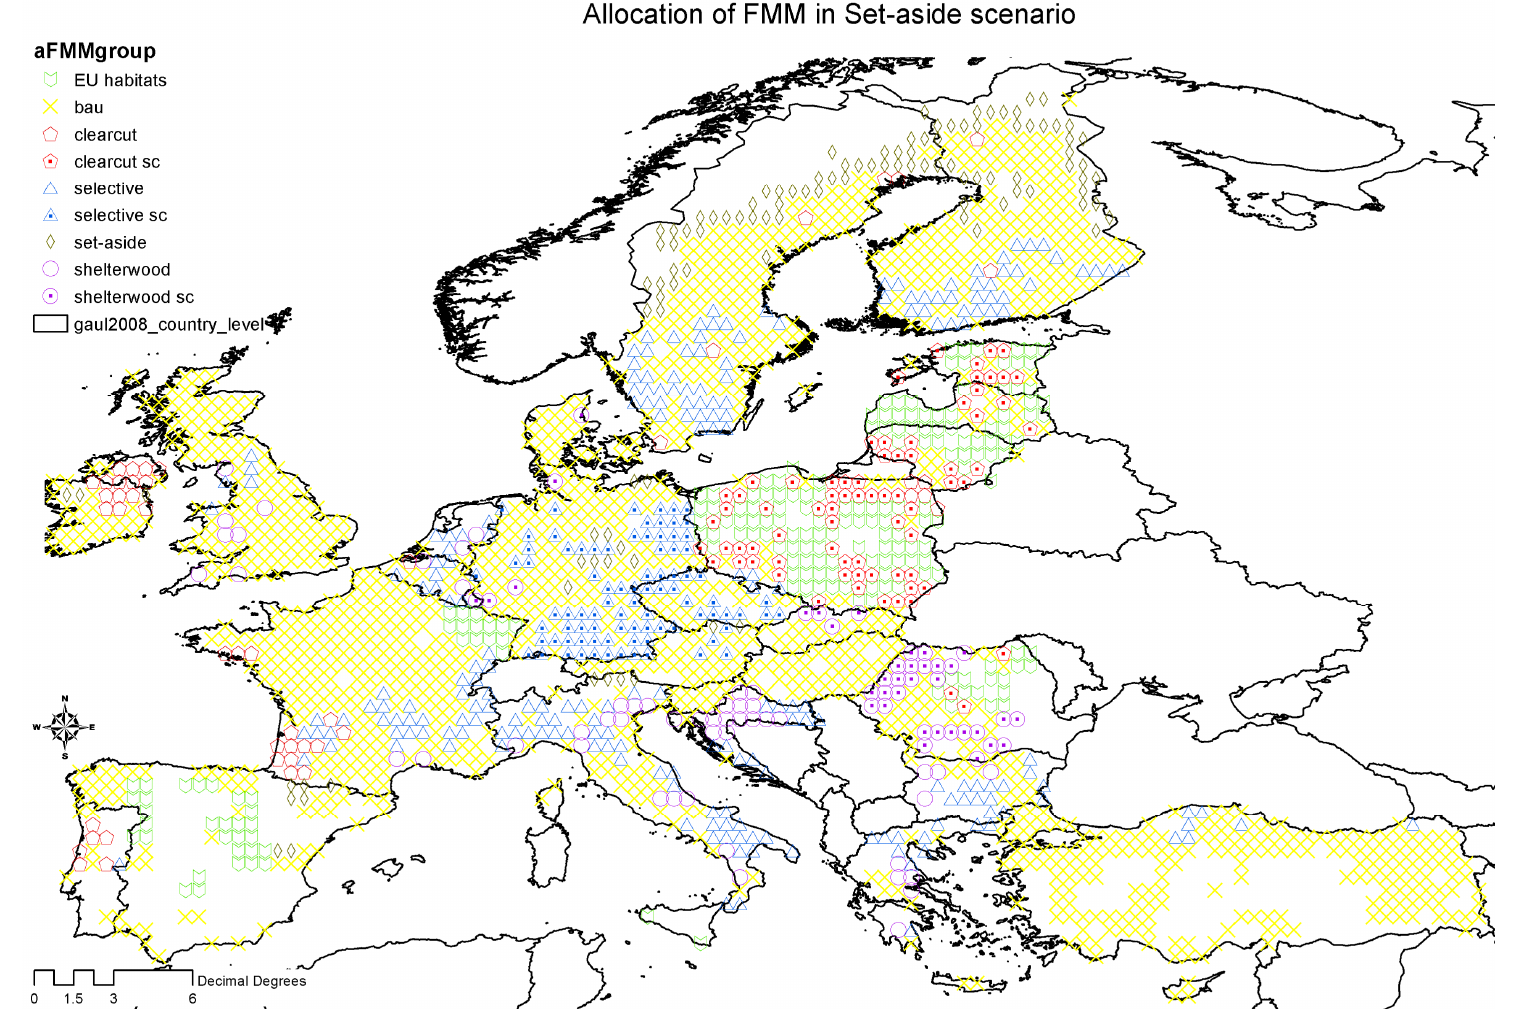
Figure A3. Allocation of the forest management models in the set-aside